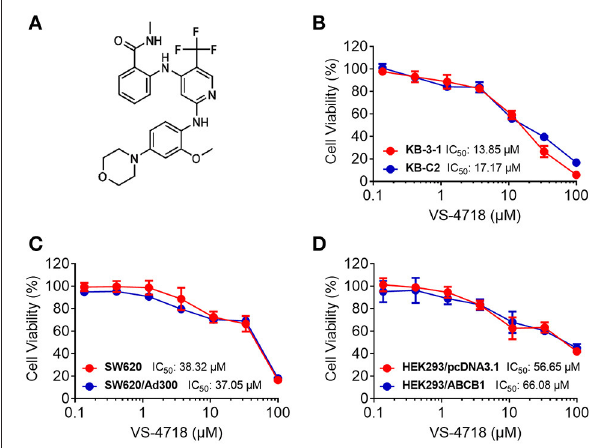
FIGURE 1 | Chemical structure of VS-4718 and concentration-dependent viability curves for parental and ABCB1-overexpressing cells incubated with VS-4718. (A) Chemical structure of VS-4718. (B) Concentration-viability curves for KB-3-1 and KB-C2 cells incubated with VS-4718 for 72h. (C) Concentration-viability curves for SW620 and SW620/Ad300 cells incubated with VS-4718 for 72h. (D) Concentration-viability curves for HEK293/pcDNA3.1 and HEK293/ABCB1 cells incubated with VS-4718 for 72h. The cell viability was determined by MTT assay. Data are expressed as mean ± SD , and representative of three independent experiments in triplicate are